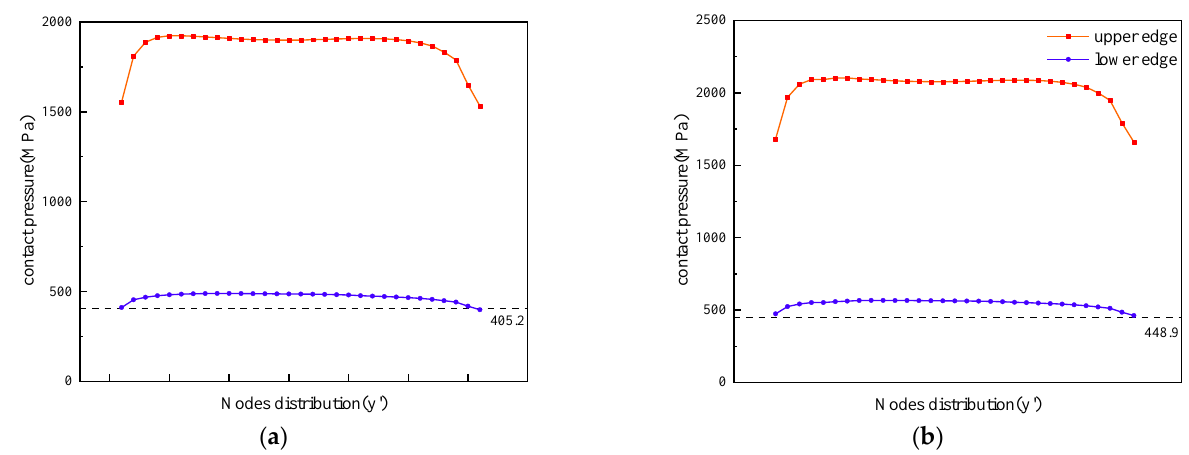
Figure 13. Peak pressure distribution at the upper and lower end of the contact surface. ( a ) 13,500N; ( b ) 16,451.6N.